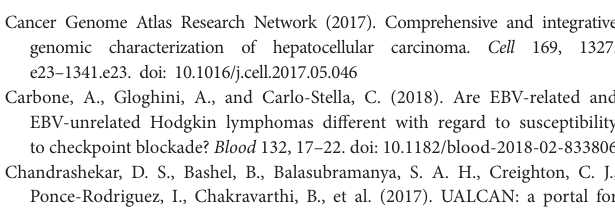
Supplementary Figure 1 | Association between IDO-1 expression and patient survival. Supplementary Figure 2 | Association between TDO-2 expression and patient survival. Supplementary Figure 3 | Association between IDO-2 expression and patient